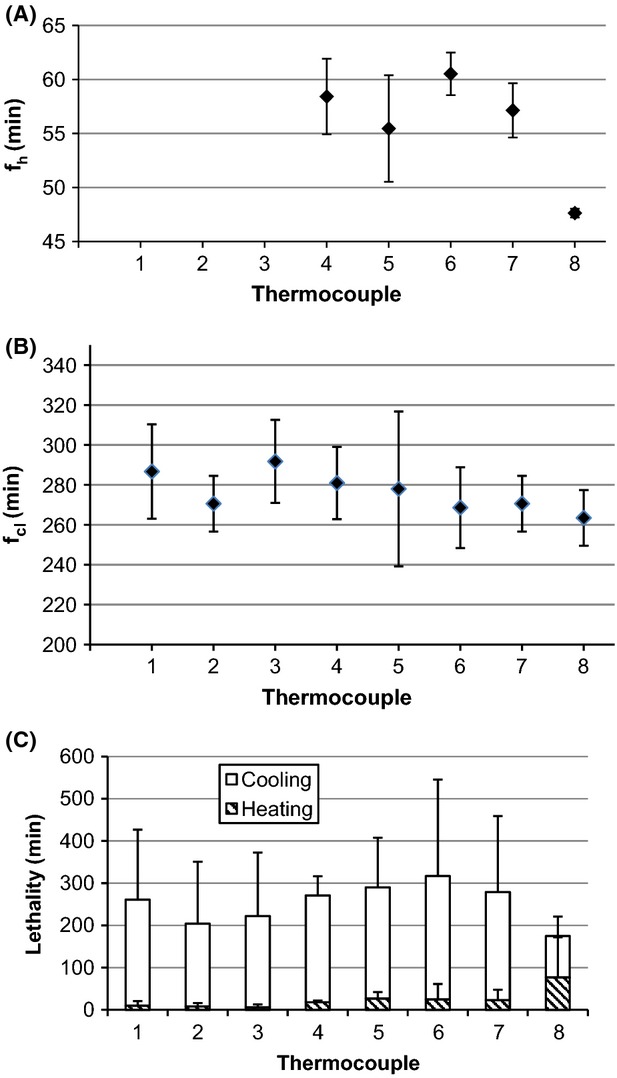
Average (95% CI) for (A) fh, (B) fcl, and (C) F82.2°C for heating and cooling of applesauce, n = 3. Thermocouple location (height from bottom of container): 7.5 (geometric center), 6.5, 5.5, 5.0 (1/3 from the bottom), 4.5, 3.5, 2.5, and 1.5 cm, for thermocouple 1–8, respectively.